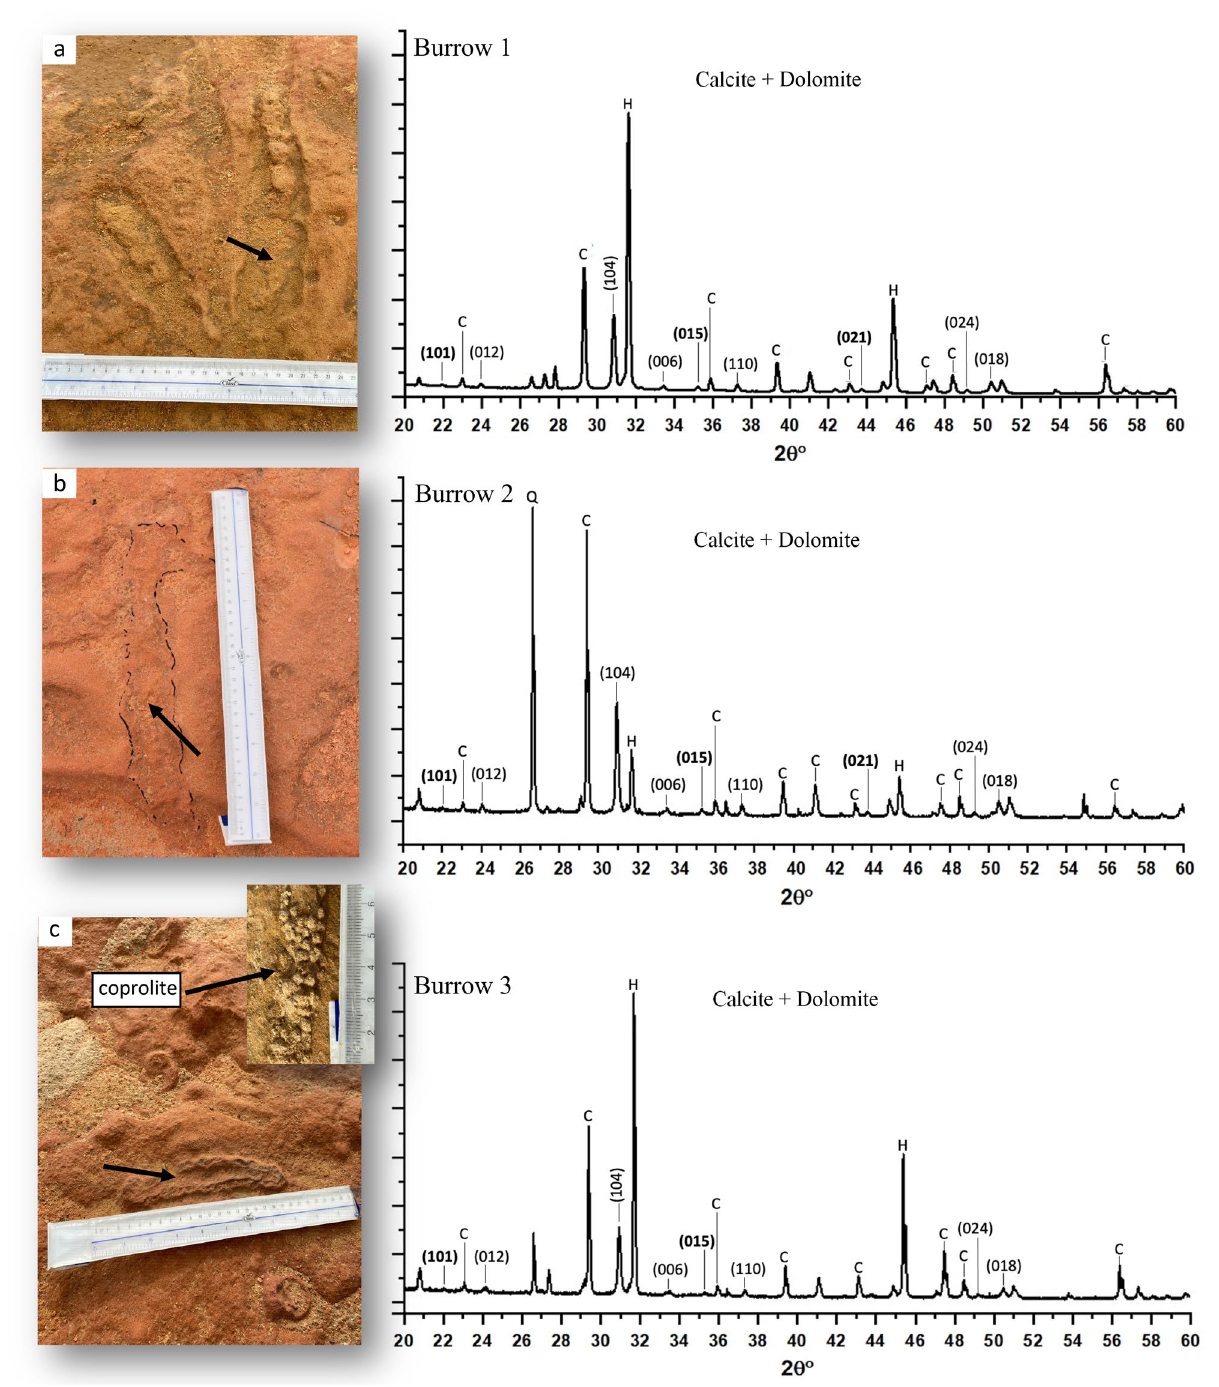
Figure 3. Strongly bioturbated zone in the marine section of the mud volcano complex adjacent to MV1 and MV2 samples (all images are top-view). ( a ) branched Ophiomorpha burrow (Decapoda). ( b ) Preserved interior burrow. ( c ) Unbranched Ophiomorpha burrow with pelleted walls, evacuated interior, and fossilized crustacean feces (coprolite). Compare this morphology to dolomitizing burrows with Gunatilaka et al. 1987. Powder XRD patterns (Cu Kα ) of the three burrows show high concentration of halite, dolomite, and calcite. Dolomite peaks were labeled based on miller indices and ordering reflections are in bold. The letters Q, C, and H correspond to quartz, calcite, and halite,